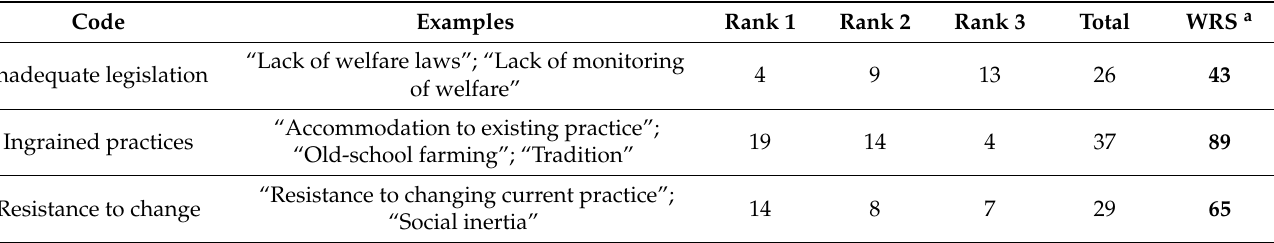
Table A2. Qualitative content analysis of veterinary perceptions concerning barriers to welfare-related change using a weighted rank score